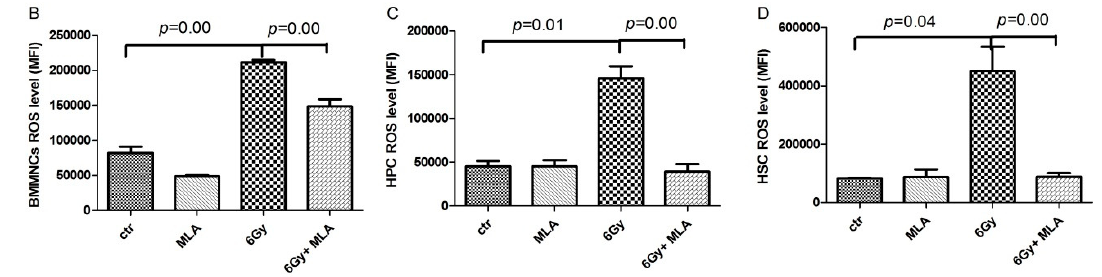
Figure 7. Effects of MLA on the levels of ROS. ( A ) A representative flow cytometry graph: The BMMNCs(P1) were firstly gated by Strepevidin–Percp and C-kit-APC, then the HPC (lin − c-kit + Sca-1 − , R2) and HSC (lin − c-kit + Sca-1 + , R3) cells were gated in the lineage negative cells (Strepevidin − , R1), and the ROS levels in these cells were further analyzed; ( B ) ROS levels in BMMNCs; ( C ) ROS levels in HPCs; ( D ) ROS levels in HSCs. Before the mice were exposed to 6 Gy TBI, they were treated